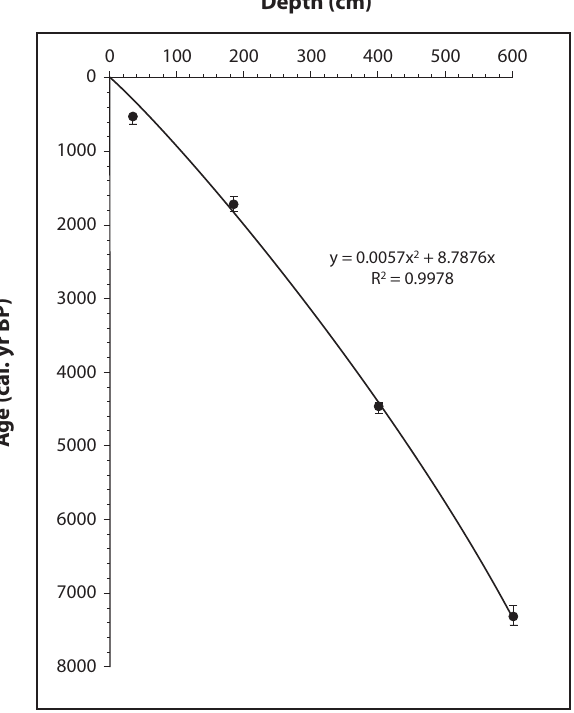
Fig. 2. Depth-age model of the core M4 of Lake Mbalang, Central